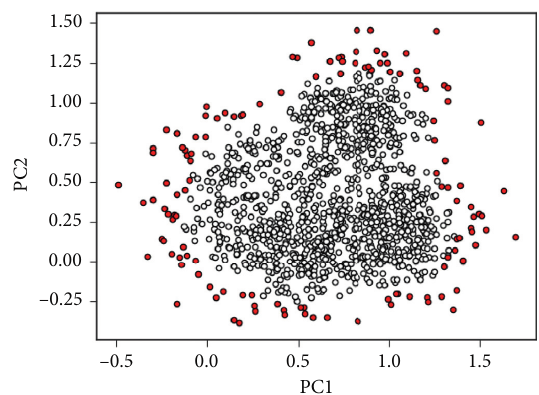
Figure 3: Anomalies detected by IF in WLFGD